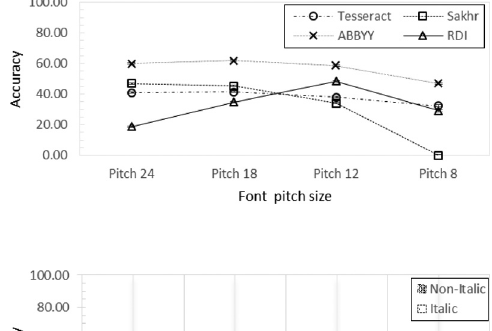
Figure 10. Italic and non-italic font accuracy comparison